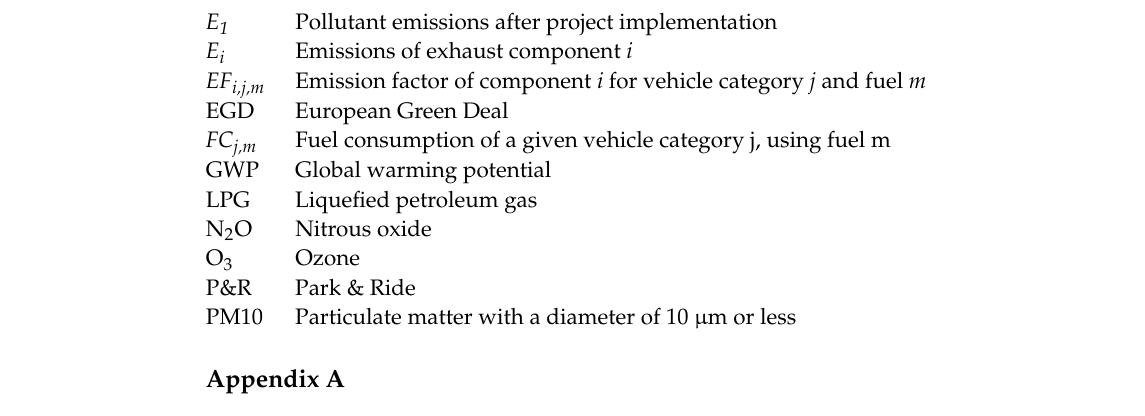
Table A1. Input to COPERT emission model—the list of the old fleet buses (left side) with the new replaced buses (right side), including basic parameters, such as EURO standard, production year, and curb